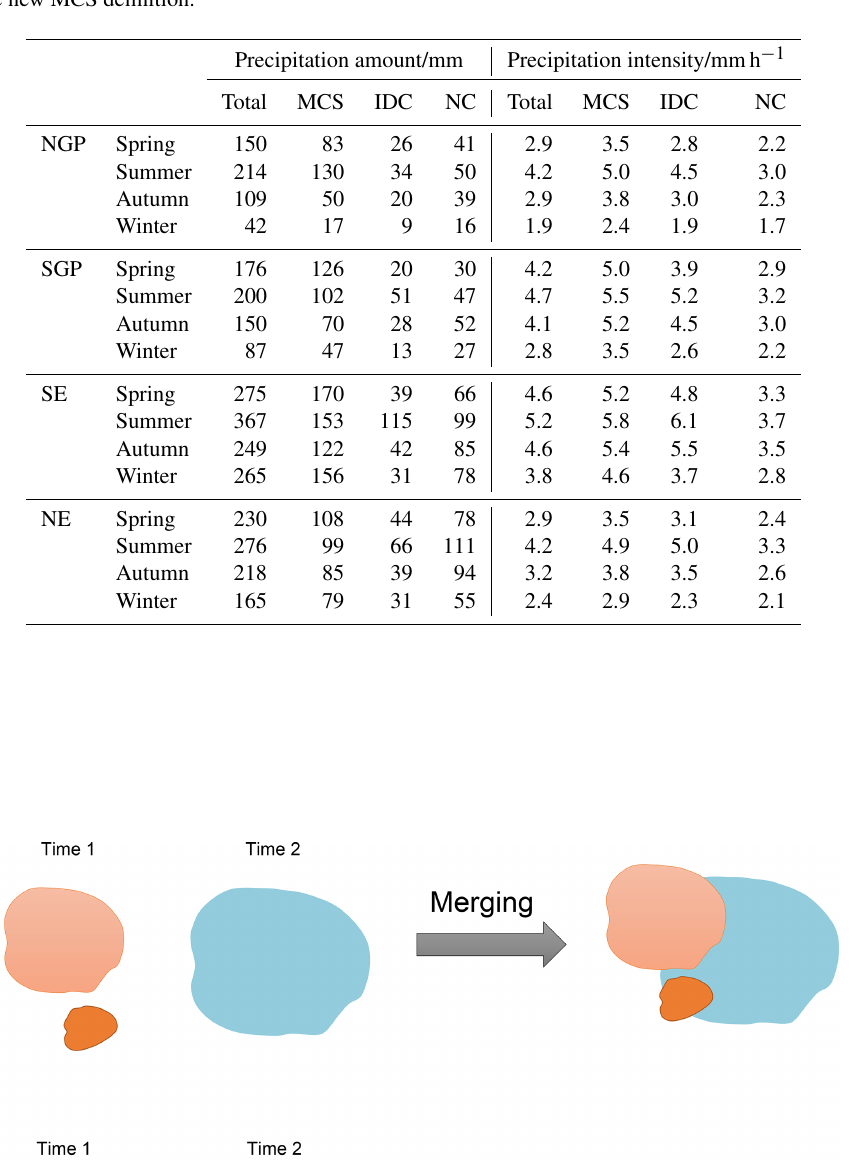
Table A7. Annual mean seasonal precipitation amounts and intensities for different types of precipitation in different regions of the US for 2004–2017 by using the new MCS definition.